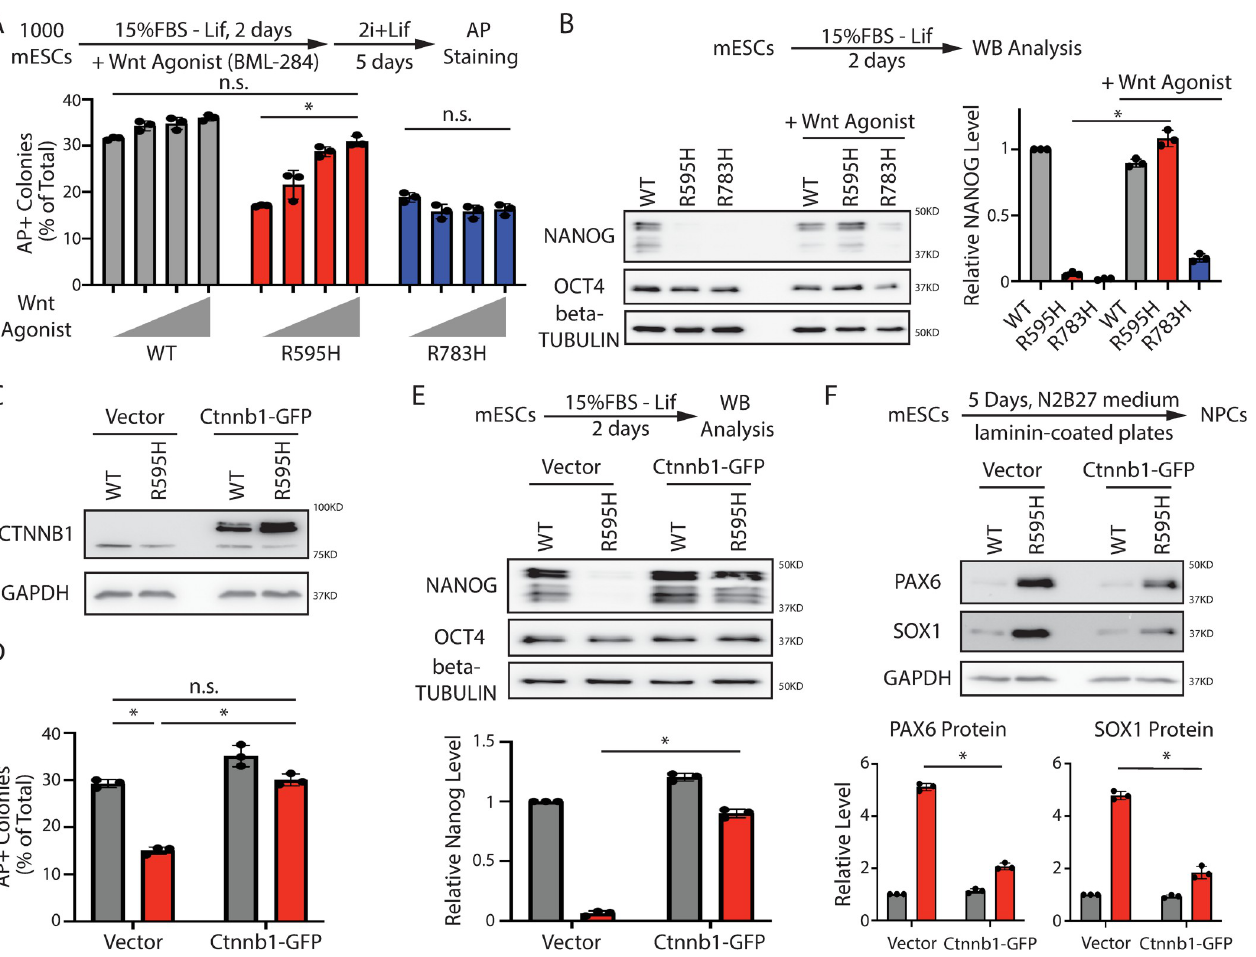
Fig 6. Enhancing the Wnt signaling specifically alleviates the differentiation defects in the R595H mESCs. ( A ) Exit pluripotency assay for mESCs in the presence BML-284. In the assay, 0, 85, 90, 95 nM BML-284 was used. ( B ) Western blotting of pluripotency factors during the spontaneous differentiation of mESCs. During the differentiation, 95 nM BML-284 was used. ( C ) Ectopic expression of Ctnnb1 in the WT and the R595H mESCs. The cells were cultured in the 2i + Lif medium. ( D ) Exit pluripotency assay for mESCs with the ectopically expressed Ctnnb1. ( E ) Western blotting of pluripotency factors during the spontaneous differentiation of mESCs with the ectopically expressed Ctnnb1. ( F ) Western blotting of neural lineage markers during the directed neural differentiation. All the quantification results represent the means ( ± SD) of three independent experiments. � p < 0.05; and n.s. not significant ( p > 0.05) by one-way ANOVA. The data for A, B, and D-F are available in S5 Data. mESC, mouse embryonic stem cell; WT,